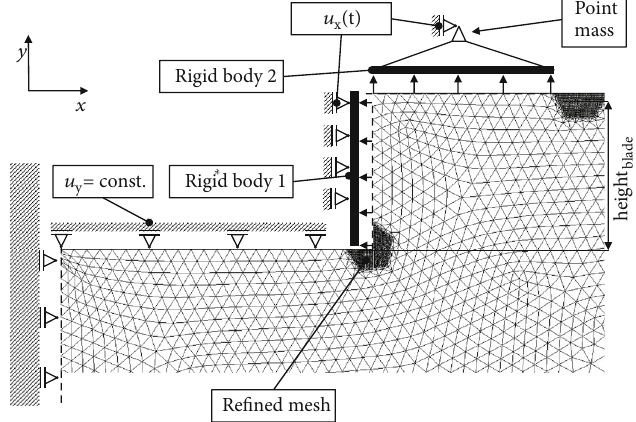
Figure 5: Detailed view of the modelling of a single cleat in soil. Table 3: Contact properties used for fi nite element model. Property Size Unit Soil-metal friction coe ffi cient 0.3 [-] Penalty sti ff ness 1e10 [-] Tangential sti ff ness 1e10